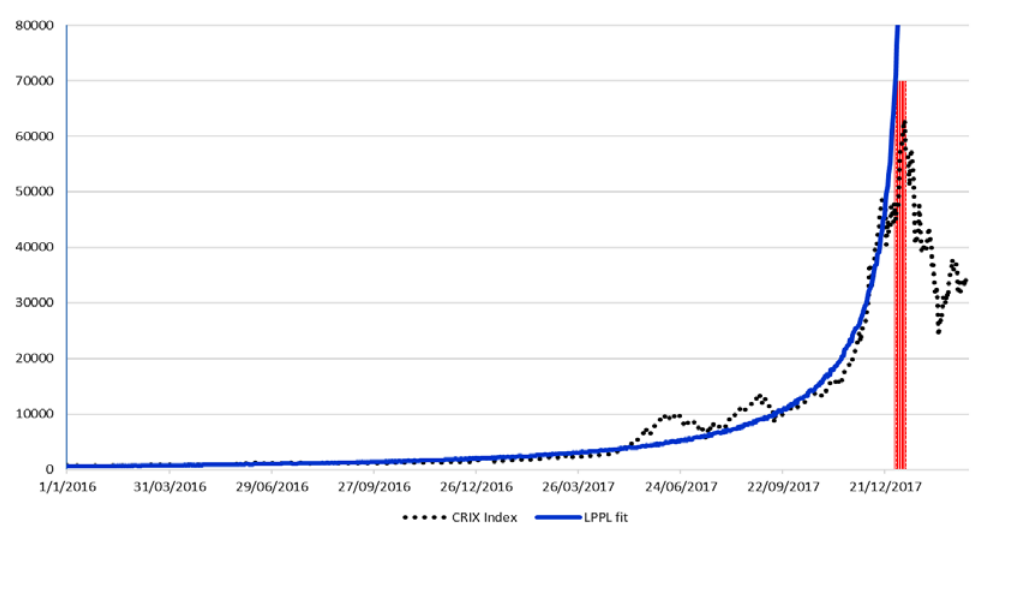
Figure 11 : LPPL fit for the CRIX index (the model with the minimum